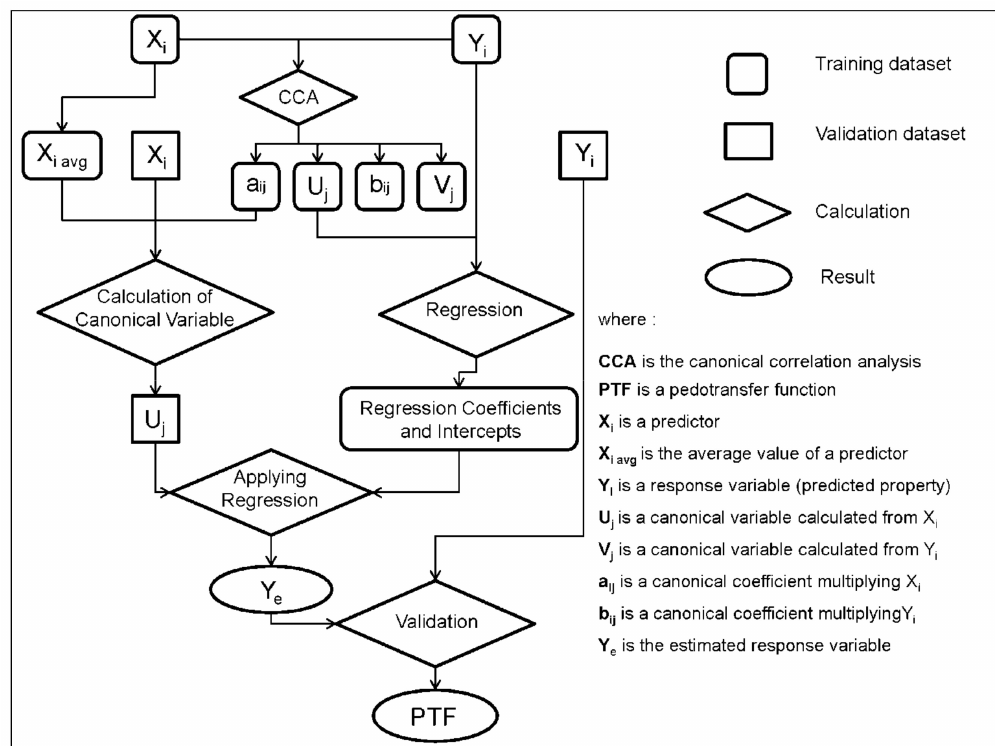
Figure 2. Development procedures of PTFs using CCA method.